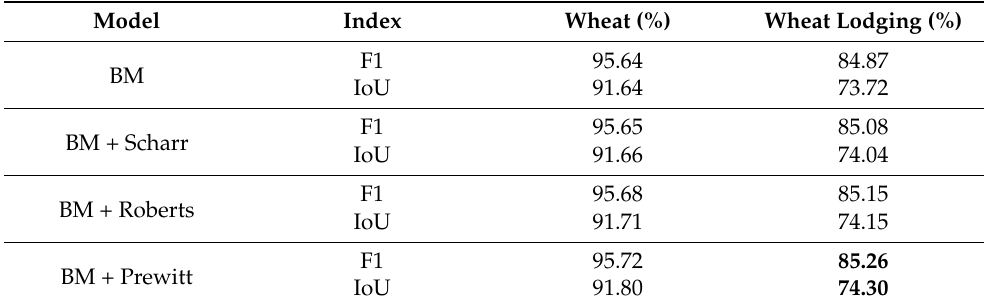
Table 5. Segmentation results comparison of using different edge operators on the test dataset.